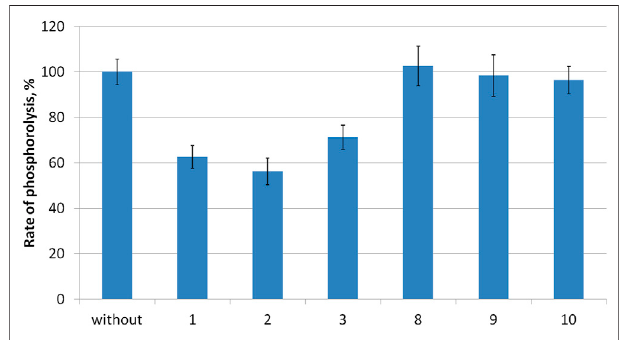
FIGURE 2 | Rate of inosine phosphorolysis and kinetic parameters of inosine phosphorolysis